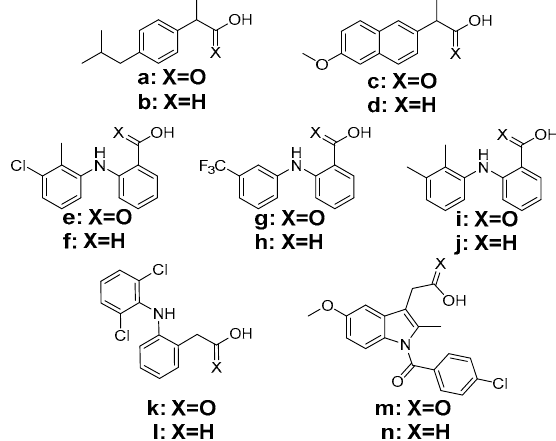
Figure 1. Structures of the used NSAIDs (acids) and their corresponding alcohols (indicated with an “-ol” suffix): ( a ) Ibuprofen; ( b ) Ibuprofenol; ( c ) Naproxen; ( d ) Naproxenol; ( e ) Tolfenamic acid; ( f ) Tolfenamol; ( g ) Flufenamic acid; ( h ) Flufenamol; ( i ) Mefenamic acid; ( j ) Mefenamol; ( k ) Diclofenac; ( l ) Diclofenol; ( m ) Indomethacin; and ( n ) Indomethacinol.